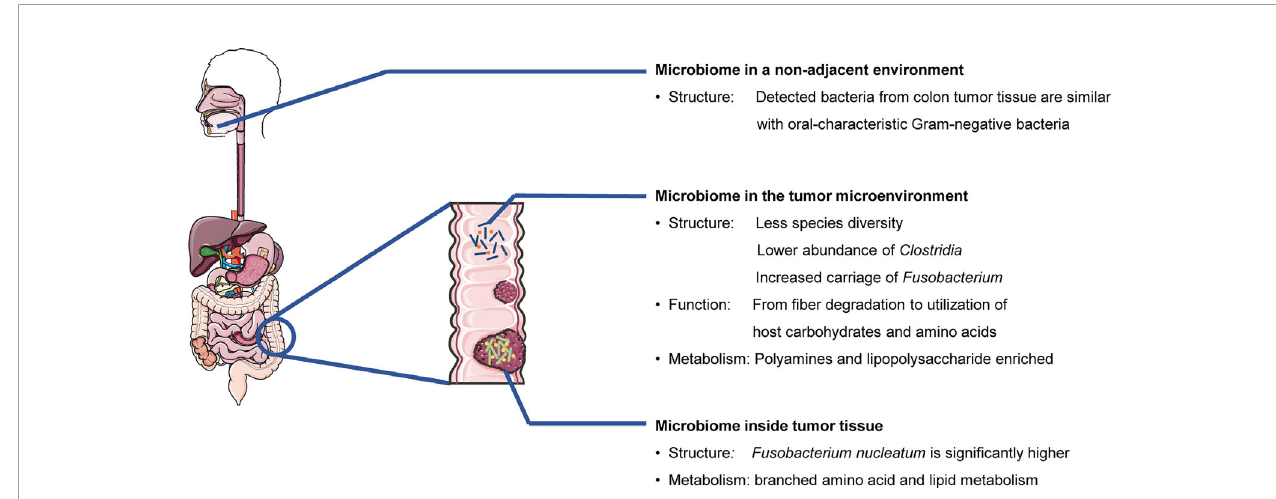
FIGURE 1 | Cancer patients and healthy individuals have different microbiomes. (Colorectal cancer and related bacteria are used as